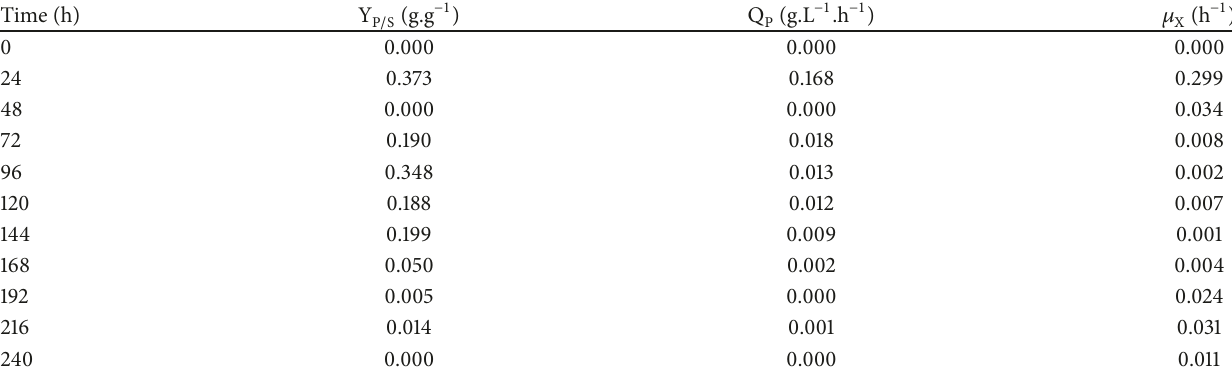
Table 3: Ethanol yield (Y residual honey by S. cerevisiae